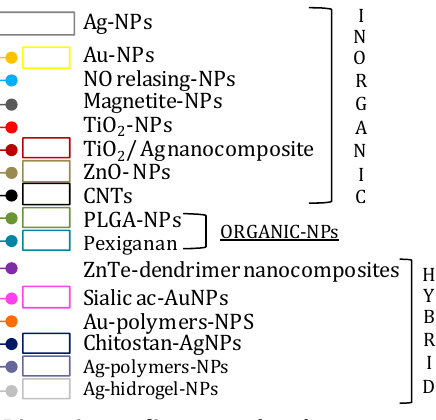
Figure 1. Representative uses of the main nanoparticles developed for the treatment of infectious diseases. Abbreviations : CNTs : Carbon nanotubes; ESBLs : expanded spectrum beta lactamases; GAS : Streptococcus group A ( S. pyogenes ); GBS : Streptococcus group B ( S. agalactia e); HPV : human papiloma virus; HSV : herpes simplex virus; IRP : Isoniazide-rifampicin-paramycin; MDR : multi-drug-resistance; MRSA : methicillin resistance S. aureus ; MRSE : methicillin resistant S. epidermidis ; NPs : nanoparticle; PLGA : poly( D , L -lactic-co-glycolic acid); SRV : syncital respiratory virus; TB : tuberculosis ( Mycobacterium tuberculosis ); VRSA : vancomycin resistant S. aureus.